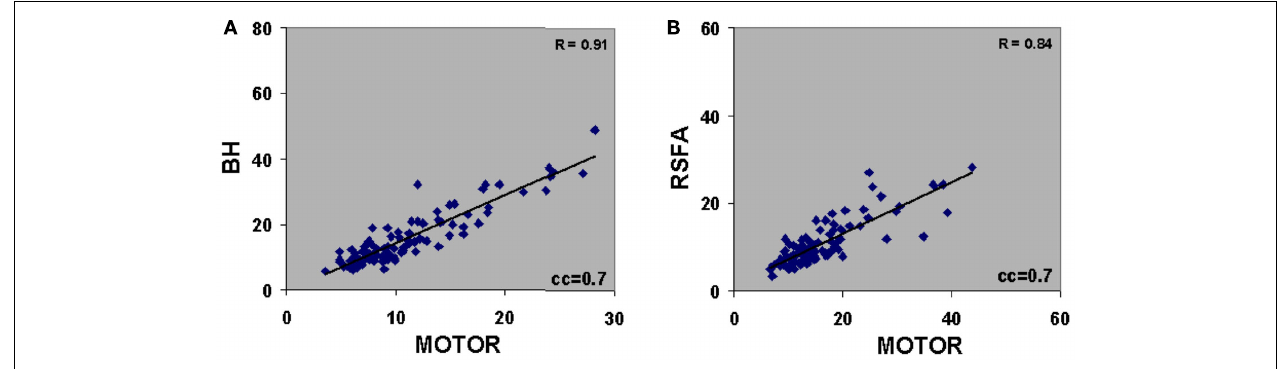
convolved motor-task reference vector.Voxels with cross-correlation coefficient (cc) ≥ 0.7 corresponding to a Bonferroni corrected P < 10 − 5 was used to generate the correlations. Plots are representative of a typical subject.